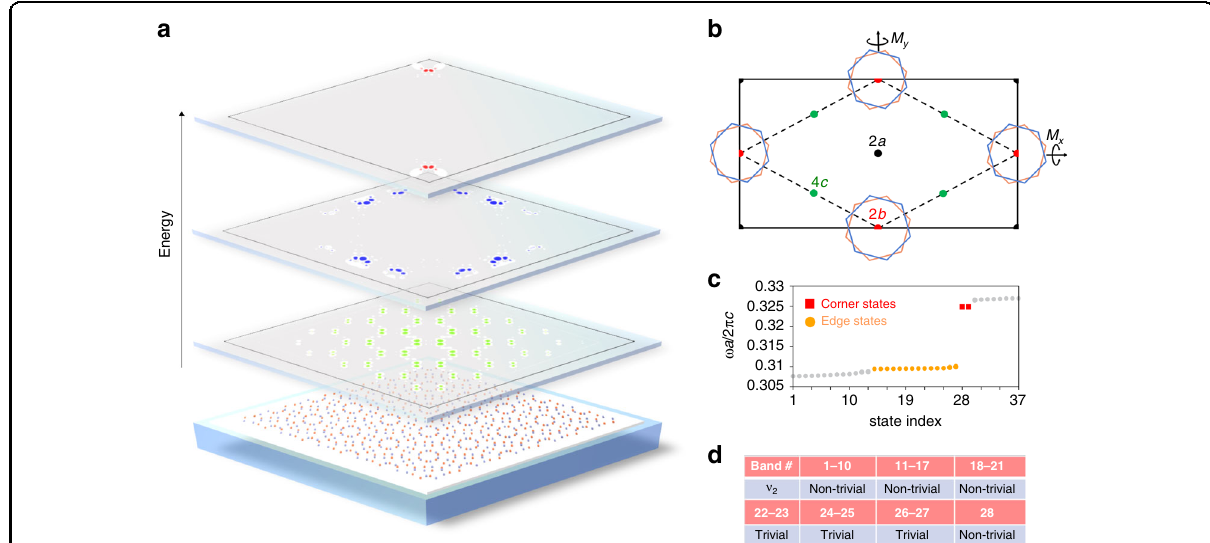
Fig. 4 Topological fl at bands and non-trivial Wyckoff positions of Wannier orbitals. a Eigenstates of the bulk (green), edge (blue), and corner (red) states in a fi nite size moiré superlattice (5 × 5 primitive unit cell). b Maximal Wyckoff positions and the mirror re fl ection symmetry in the unit cell. The dashed line represents the primitive unit cell. The rotational center of the twist corresponds to the Wyckoff position 2b. LSWs in the innermost dodecagonal quasi- atoms form OAL2b. c Energy eigenvalues in fi nite size systems. The red square and yellow circle represent the corner and edge states, respectively. Gray dots represent the bulk states. d Table representing the second Stiefel – Whitney number of each global band gap. The second Stiefel – Whitney number is determined by the number of the inversion-odd bands at the TRIM